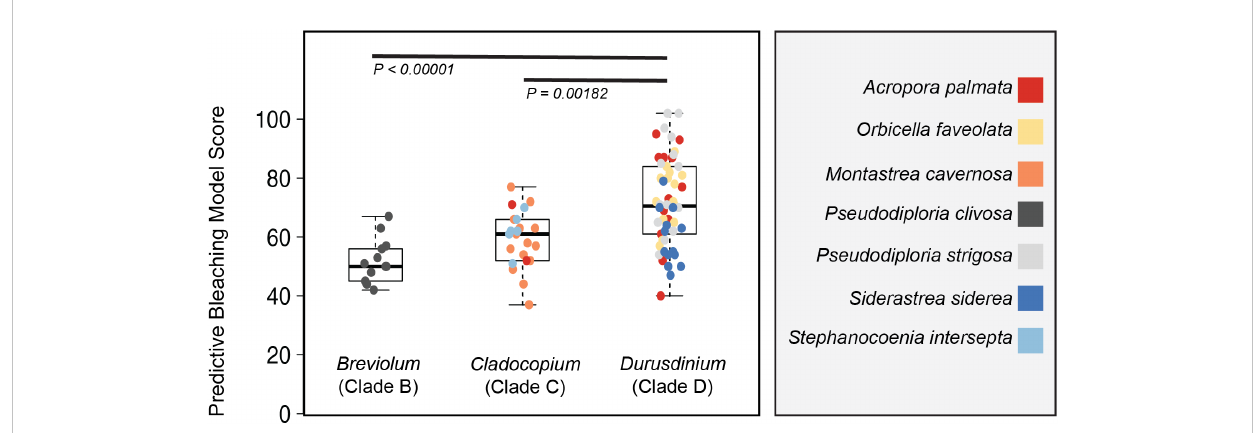
FIGURE 5 Model output on clade level comparisons. A reduced model containing only 261 of the original 1973 comparisons was applied to photo physiological data from each of the 90 coral fragments represented in Figure 3. Box plots represent the mean and ± 1 standard deviation of model output for Symbiodinium, Breviolum and Durusdinium- dominated corals. Signi fi cant differences between symbiont types are indicated by black bars. Individual coral fragments are also plotted with color re fl ecting coral